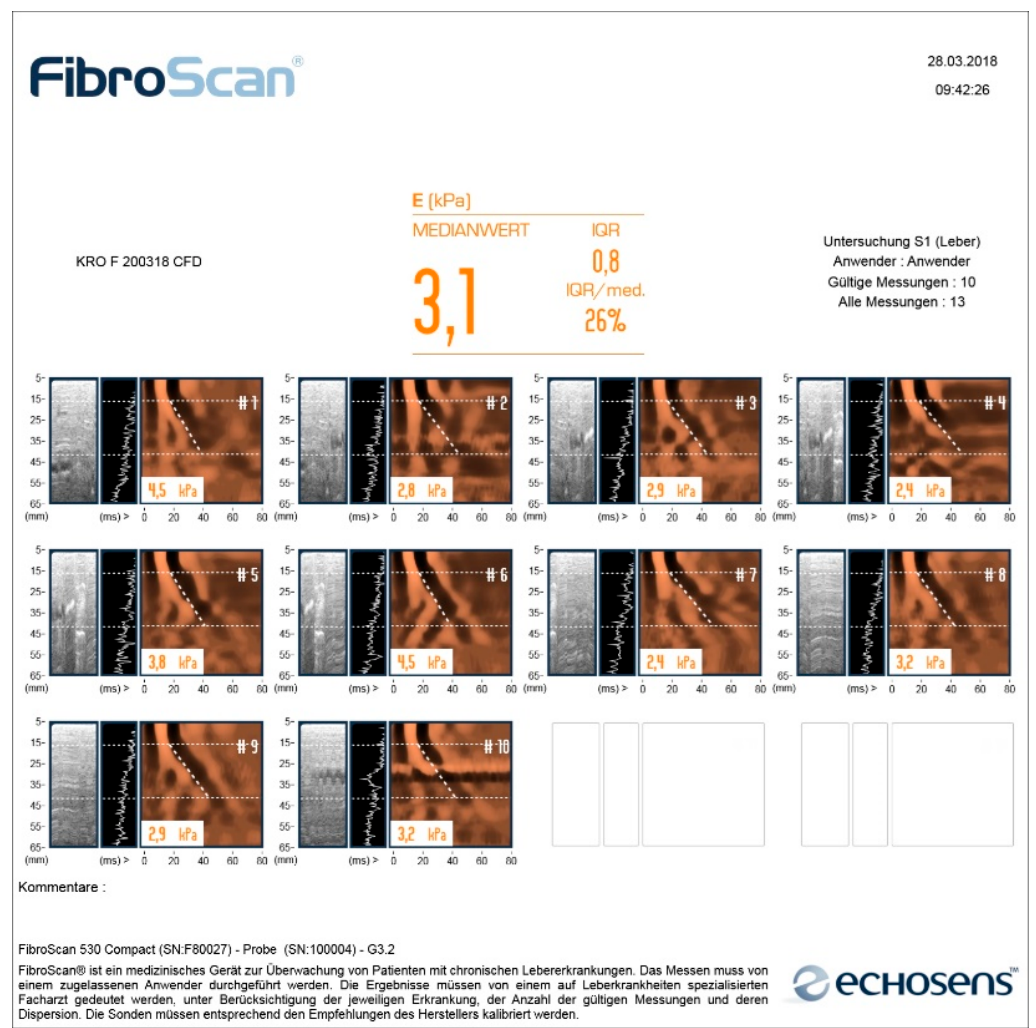
Figure 1. Transient elastography (TE) (S1 probe) in a newborn with alpha-1 antitrypsin deficiency. The individual values of 10 measurements are shown as well the median of the 10 measurements and two quality parameters, the interquartile range and the interquartile range divided by the median.